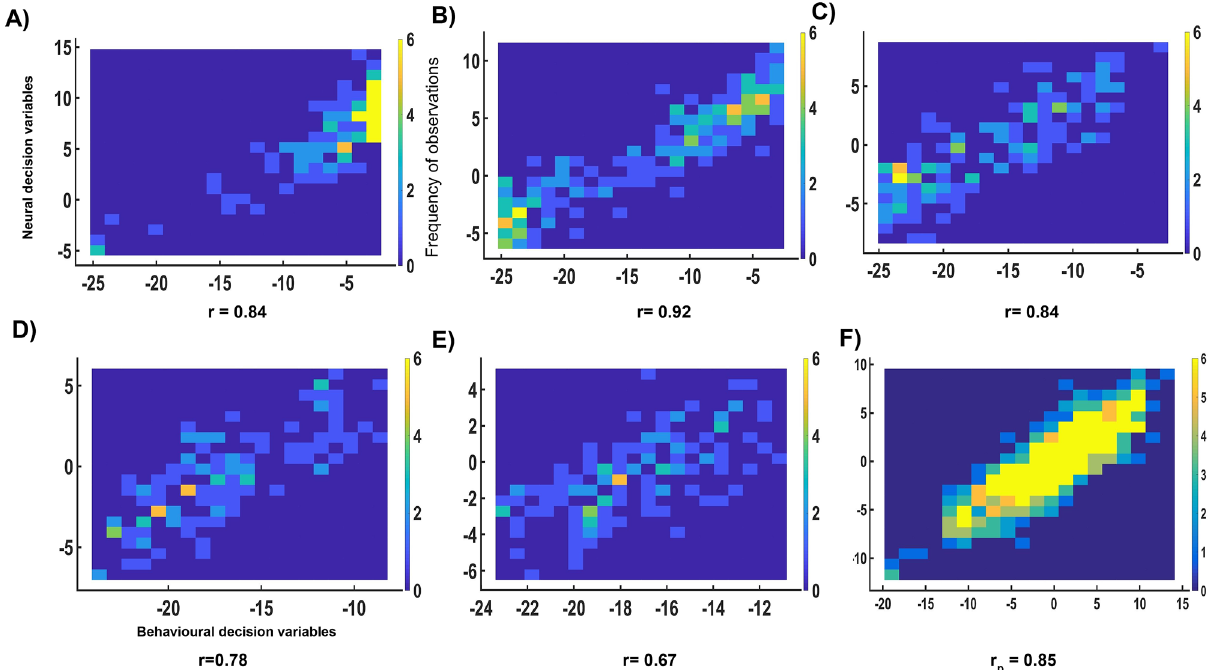
Figure 4. Relationship between Behavioural and Neural Decision Variables ( A )–( E ) Relationship between the behavioural and neural decision variables from the training data across difficulty levels 1 to 5. ( F ) Partial correlation between the behavioural and neural decision variables from the training data after controlling for effect of difficulty. Colour bars represent the frequency of observations.